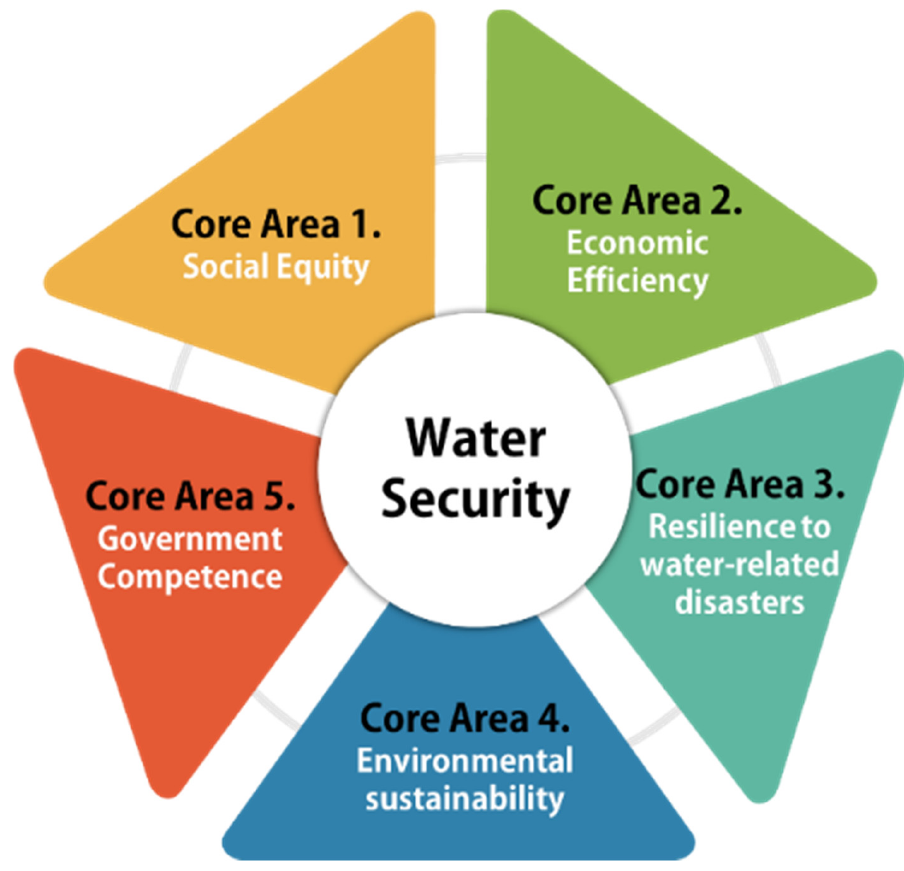
Figure 1. Water security assessment framework.